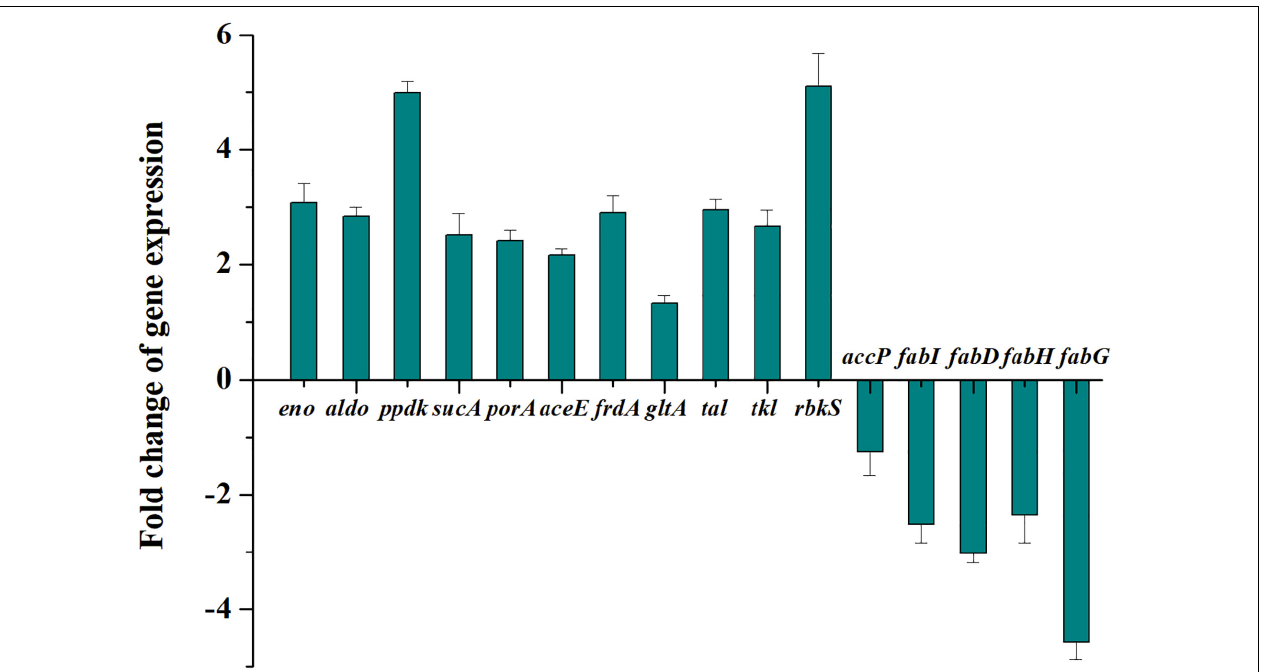
FIGURE 2 | Transcription changes of 16 selected key genes related to central carbon metabolism in P. acidipropionici after combined metabolic and evolutionary